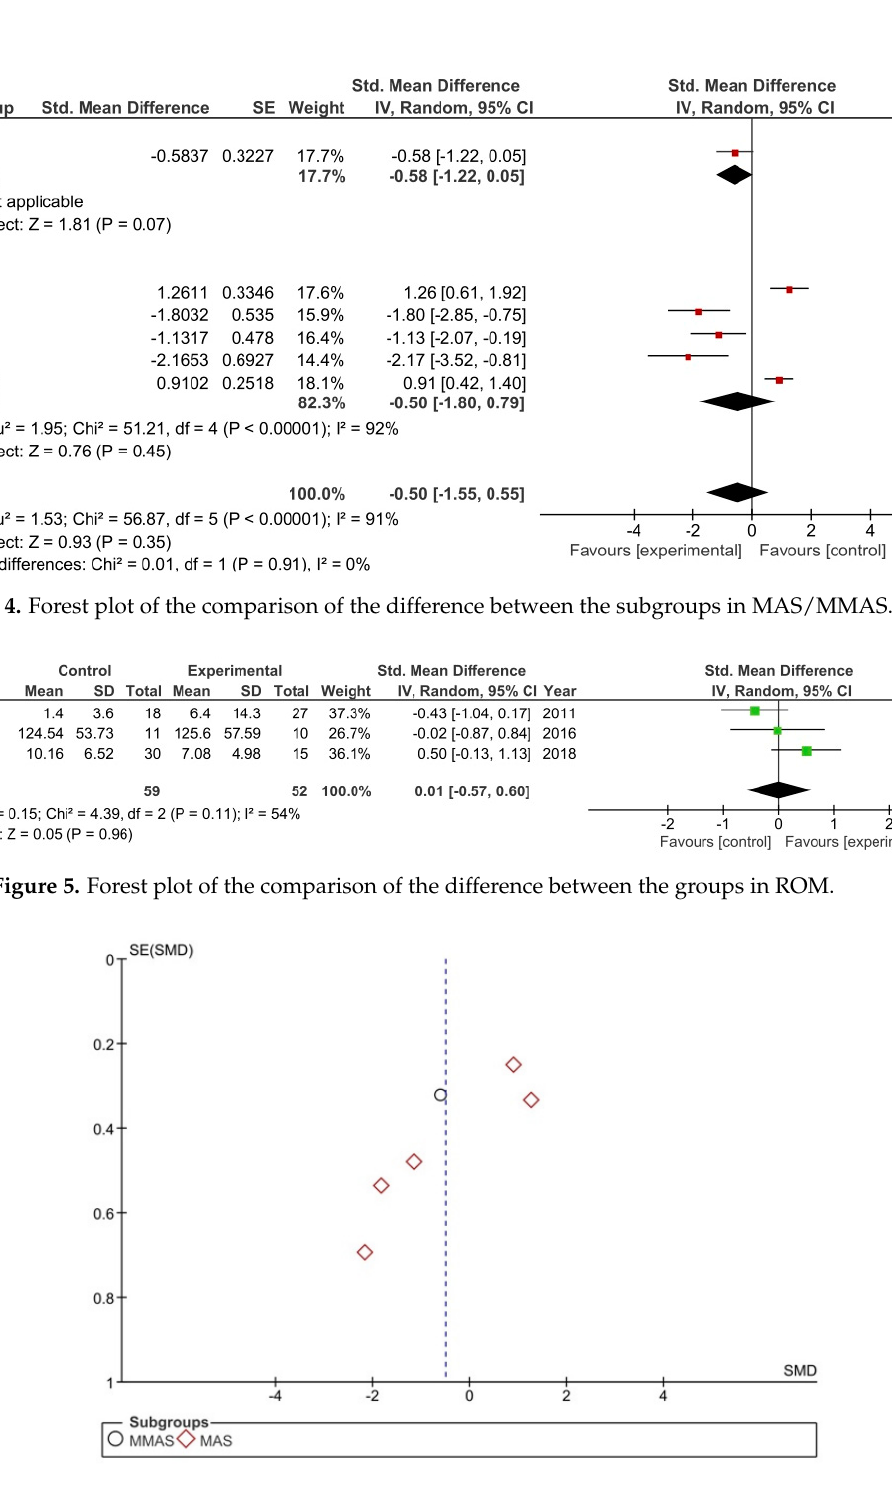
Figure 6. Funnel plot panel of the comparison of the difference between the subgroups in MAS/MMAS.